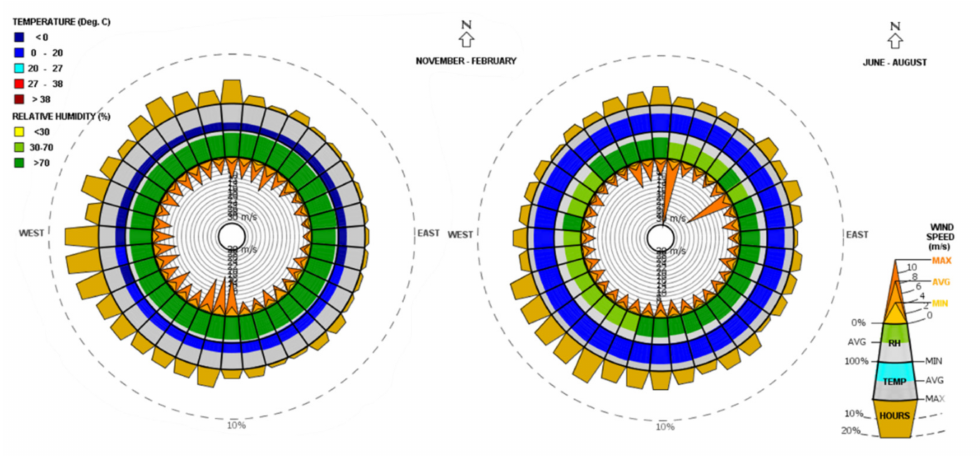
Figure 10. Prevailing winds in winter and summer, Stockholm,